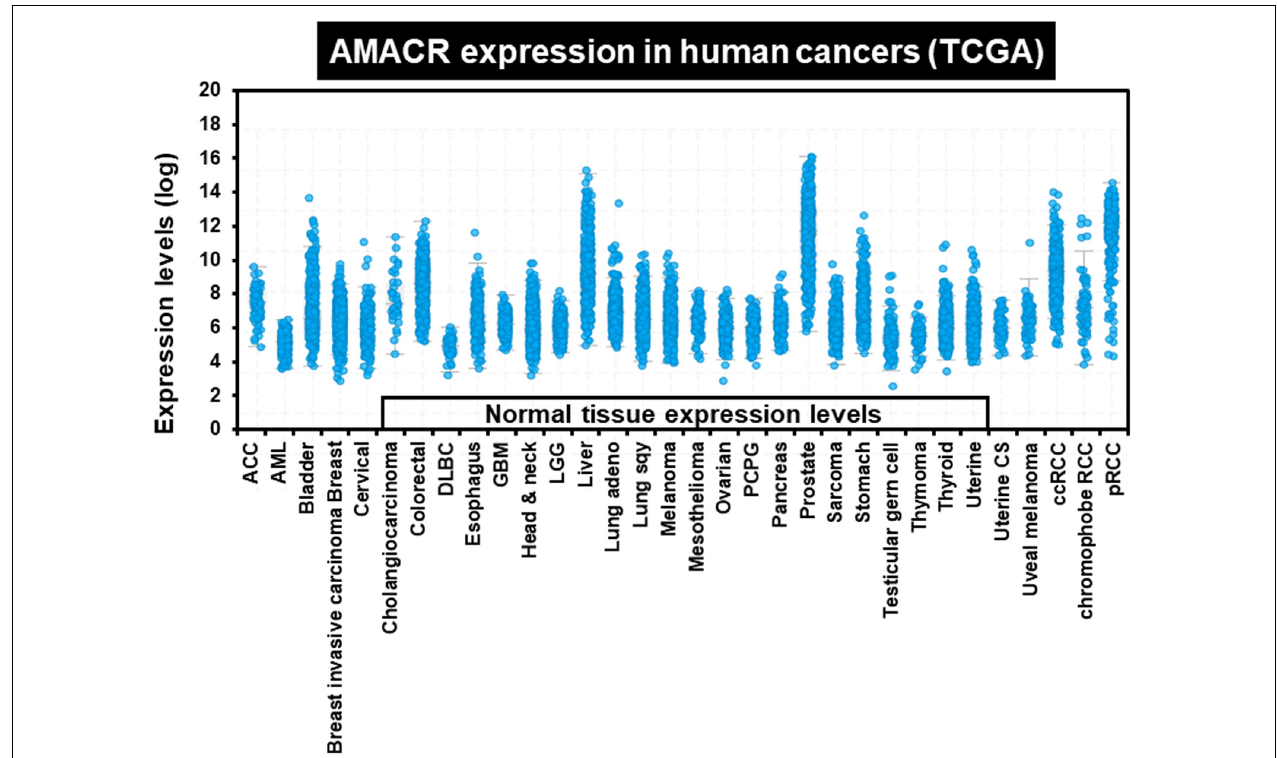
FIGURE 3 | Increased expression of AMACR in 32 different human cancers. AMACR expression levels in various human cancers identified by TCGA statistics. High expression of AMACR was observed in 32 different cancers [adapted from Lee (2019)].